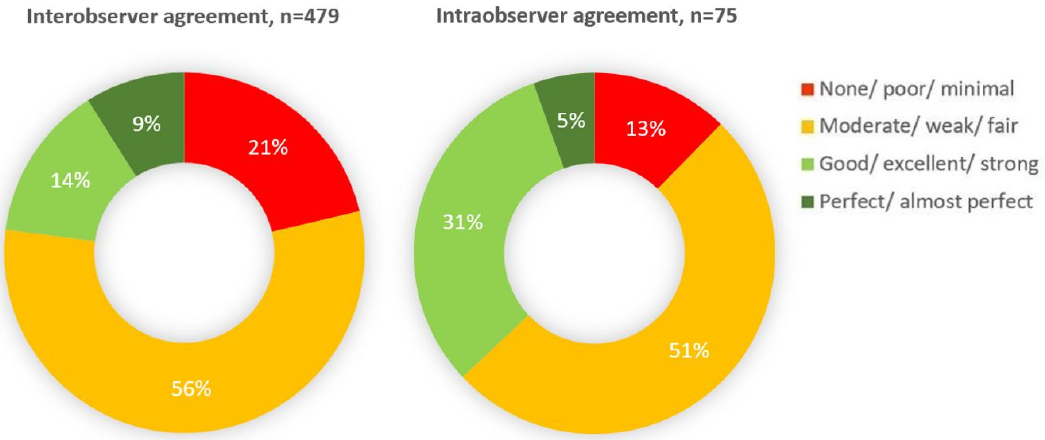
Figure 2. Distribution of agreement evaluations stratified by inter/intra-observer agreements.